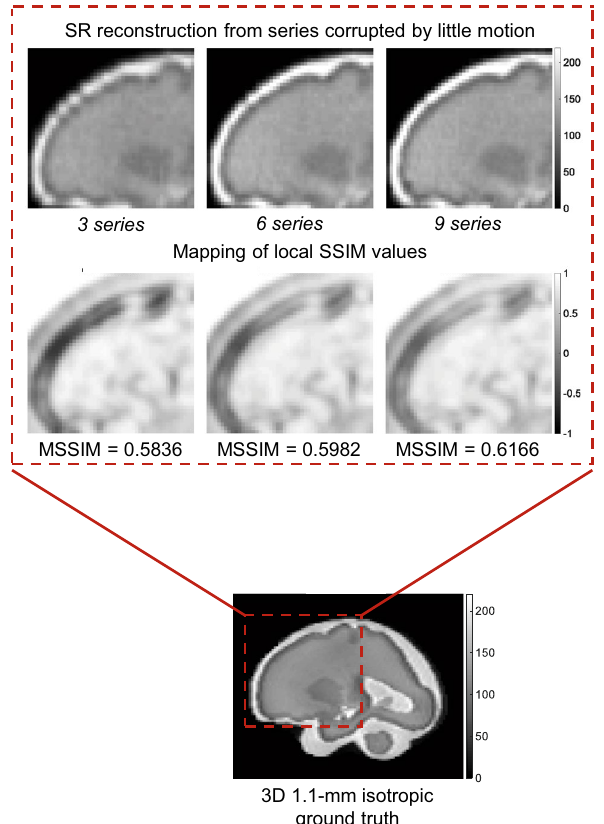
Figure 6. Appreciation of sharpness and tissue contrast enhancement in SR reconstructions from higher numbers of simulated orthogonal LR HASTE images corrupted by little motion at a GA of 30 weeks in comparison with the corresponding static 3D HR ground truth. The frontal cortex looks smoother and the putamen area sharper in the SR reconstruction from nine series compared to the SR reconstruction from three series. The mapping of local SSIM values and the computation of the MSSIM over the corresponding region-of- interest further support these